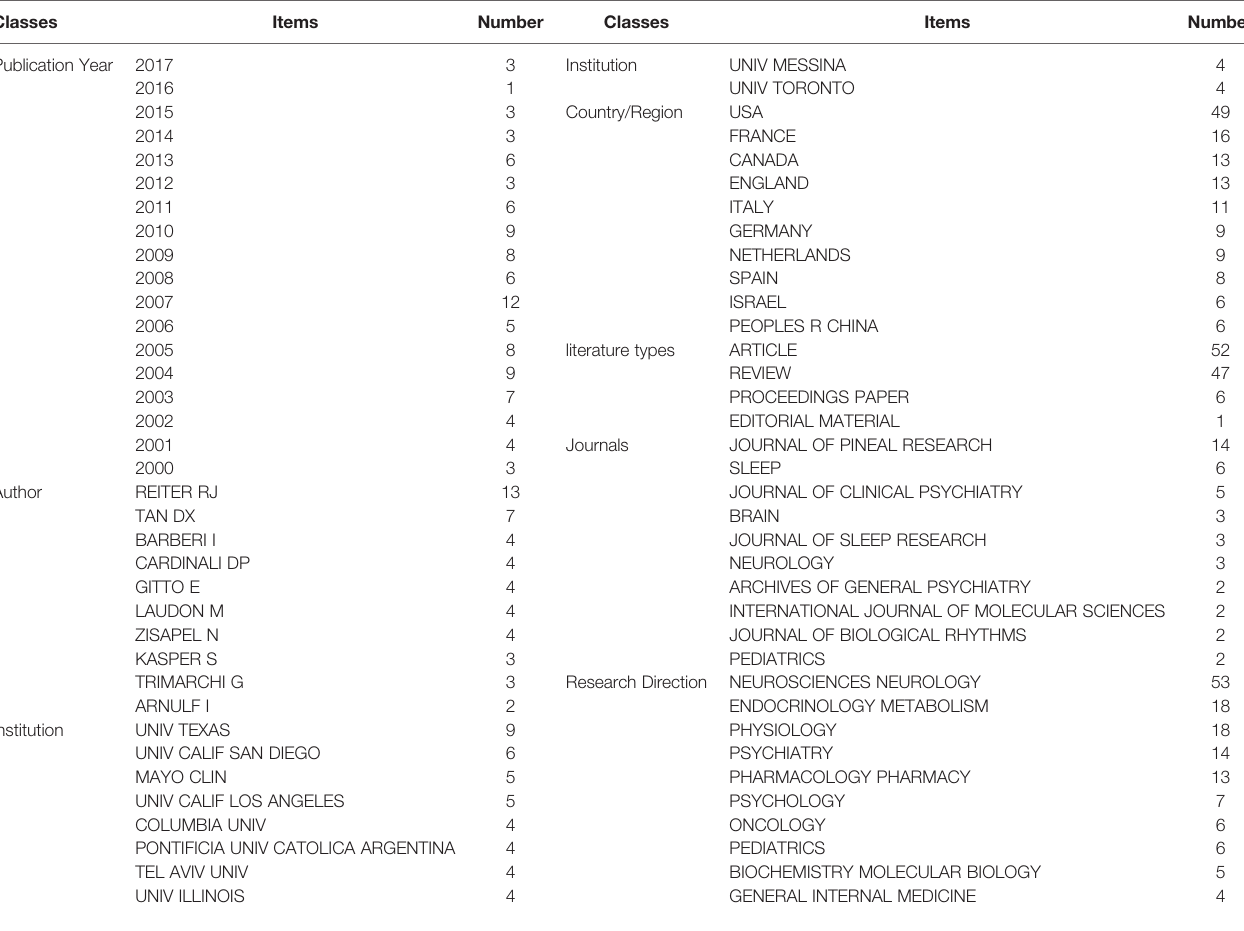
TABLE 5 | Publication of the 100 most-cited articles on melatonin research.